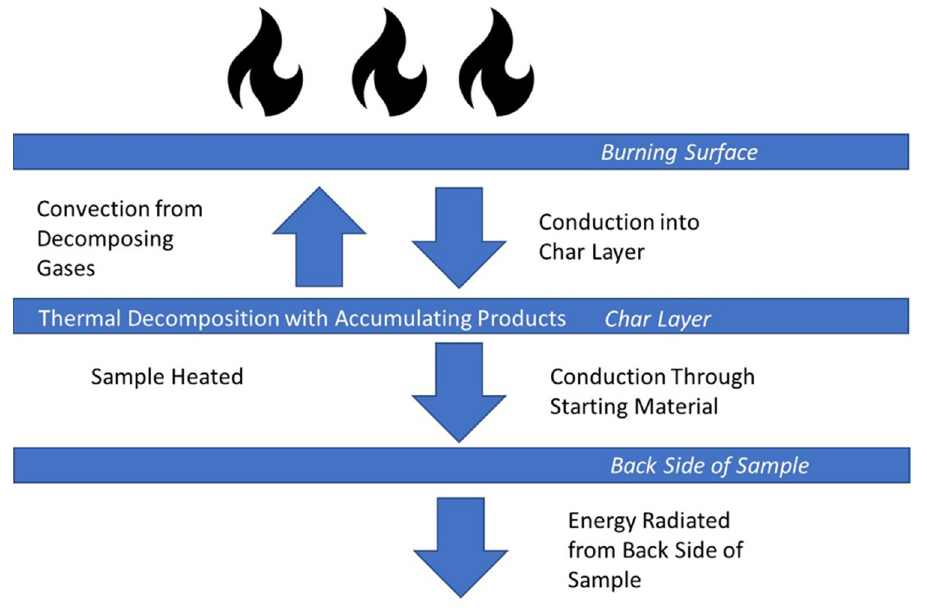
Figure 1. Thermal energy transfers [8].